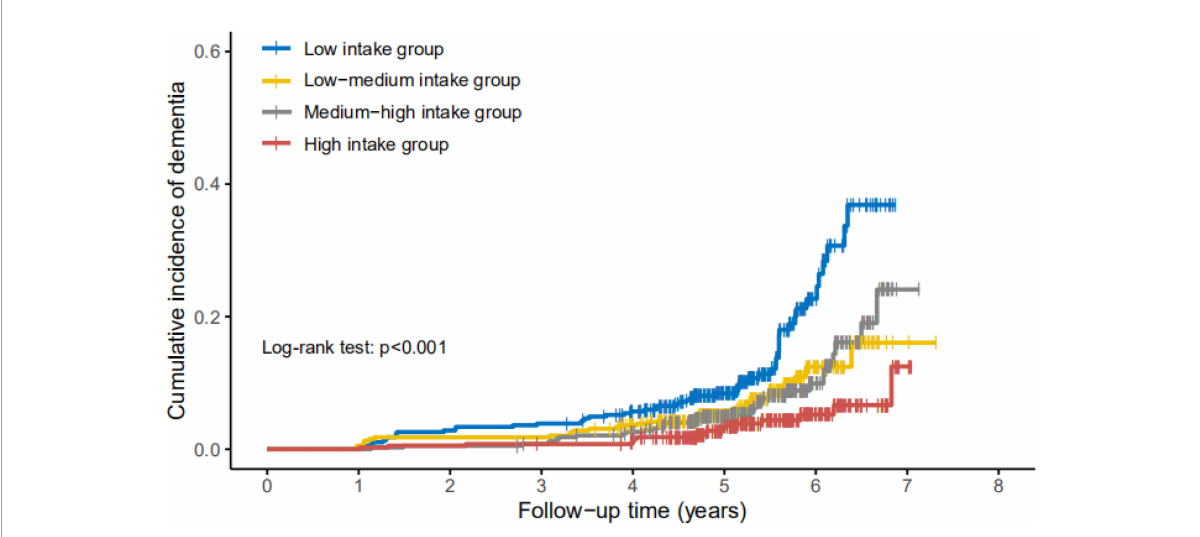
FIGURE1 Cumulative incidence of dementia in participants with different levels of daily intake of vitamin E. Cumulative incidence rate of dementia increased most dramatically during the follow-up in participants with vitamin E low intake ( < 13.20 mg/d, n = 387), followed by low-medium intake group (13.20–17.54 mg/d, n = 388), medium-high intake group (17.54 and 23.63 mg/d, n = 388), and high intake group ( > 23.63 mg/d, n = 387), resulted by Kaplan–Meier curve with log-rank test, p =